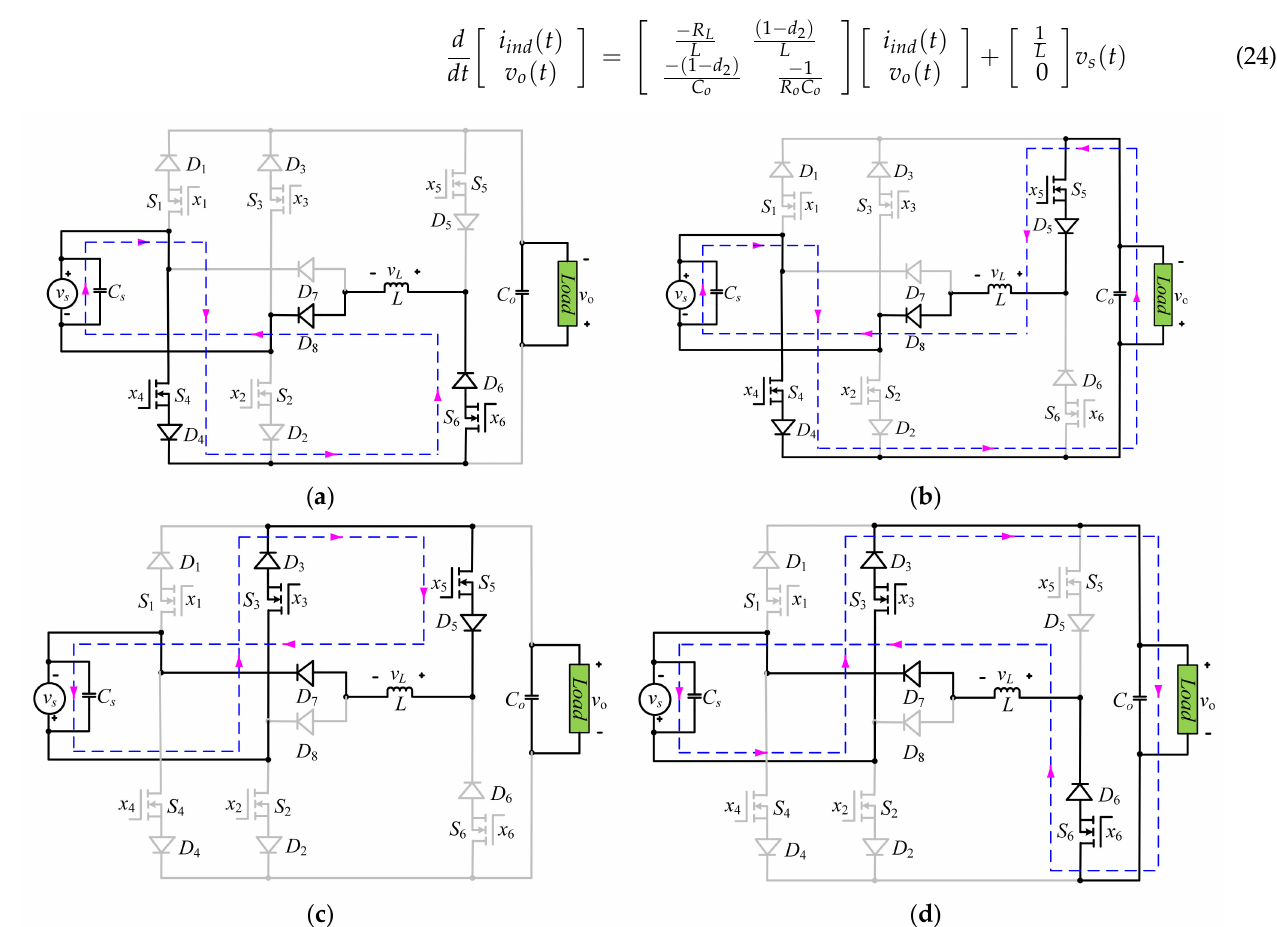
Figure 6. Equivalent current-conducting loops with respect to the input voltage to produce inverting boost operation during: ( a , b ) positive half cycles; ( c , d ) negative half